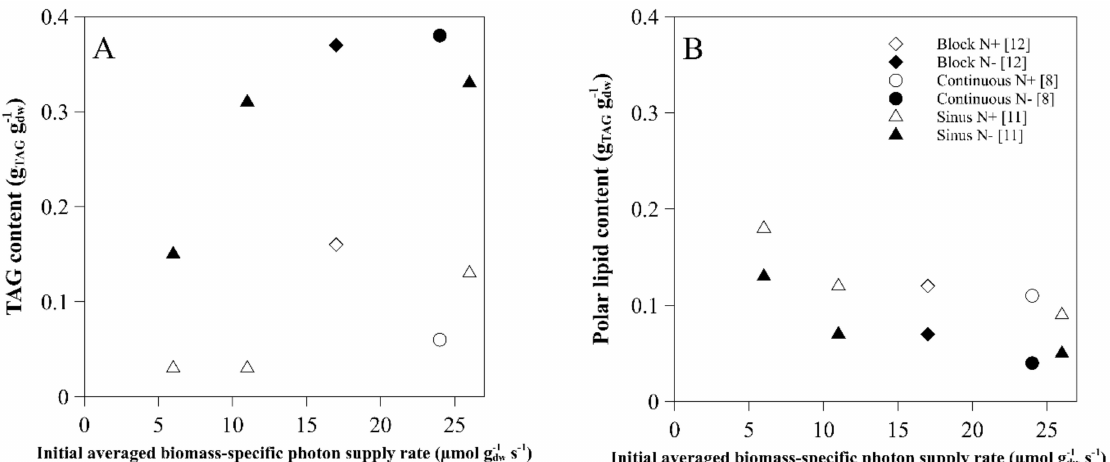
Figure 4. TAG ( A ) and polar lipid ( B ) content (g TAG g dw − 1 ) at the start of nitrogen starvation (white) and after 14 days (12 days for 26 µ mol g dw − 1 s − 1 ) of nitrogen starvation (black) for the different average biomass-specific photon supply rates ( µ mol g dw − 1 s − 1 ) at the onset of nitrogen starvation. The light regime used: continuous (circles), sinus (triangles) and block (diamonds)